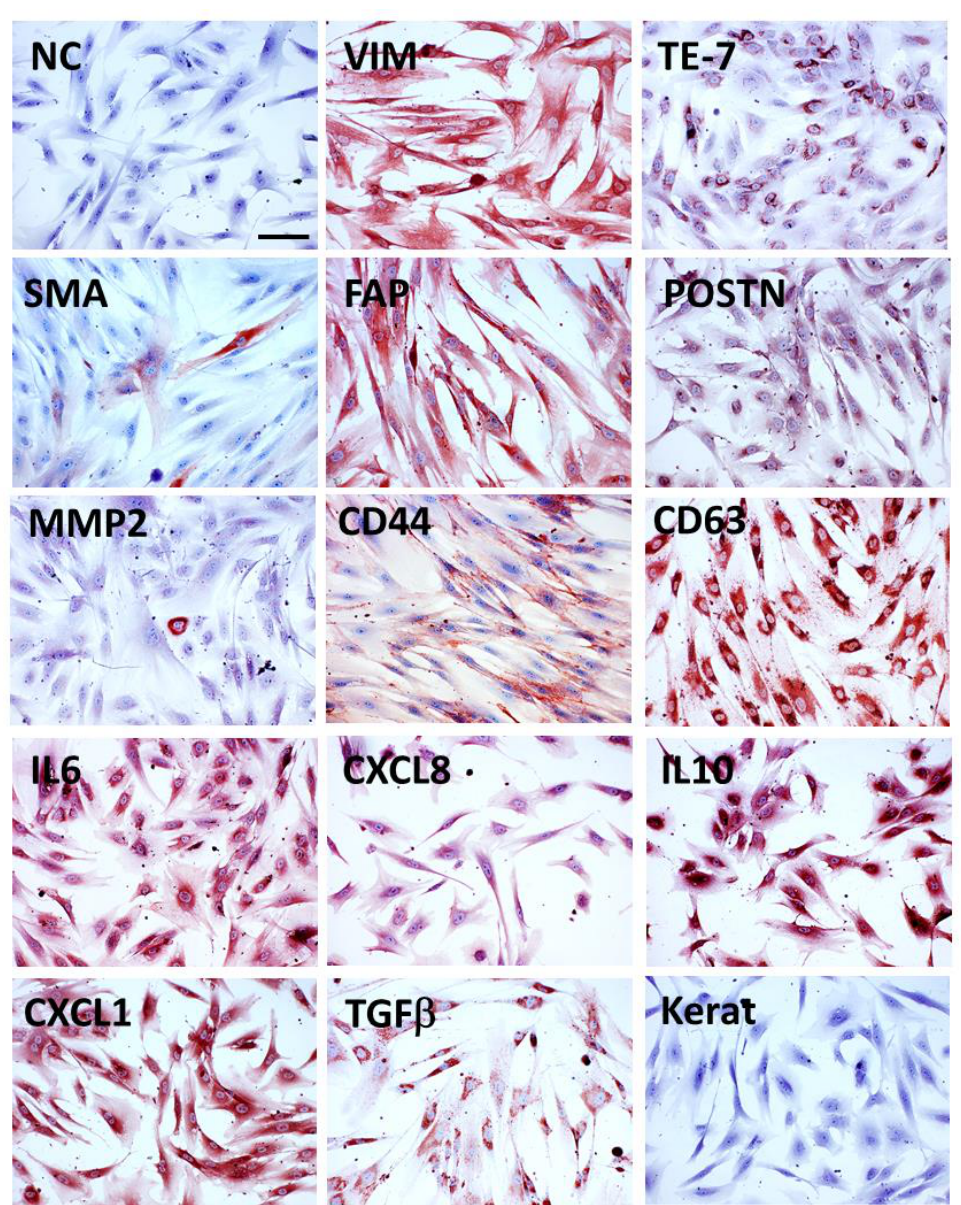
Figure 1. CAFs isolated from human cutaneous basal cell carcinoma (immunocytochemical analysis, red AEC product indicates positive reaction, NC—negative control with isotype antibody, bar rep- resents 100 µ m). CAFs are expressing intermediate filament protein vimentin (VIM), and specific mesenchymal marker TE-7. SMA was detected only in a minority of cells, while FAP was present universally, and periostin (POSTN) was also found in virtually all cells. MMP2 was positive only in sporadic cells. CD44 (hyaluronic acid receptor) was widely expressed with marked positivity on the periphery of cells. Tetraspanin CD63 is associated with the membranes of intracellular vesicles and was detected in all cells as a distinct granular signal. CAFs produce high quantities of interleukins and chemokines, such as IL-6, CXCL-8, IL-10, CXCL-1, and TGF- β . Despite using pan-keratin reactive antibodies, no keratin positivity was observed in